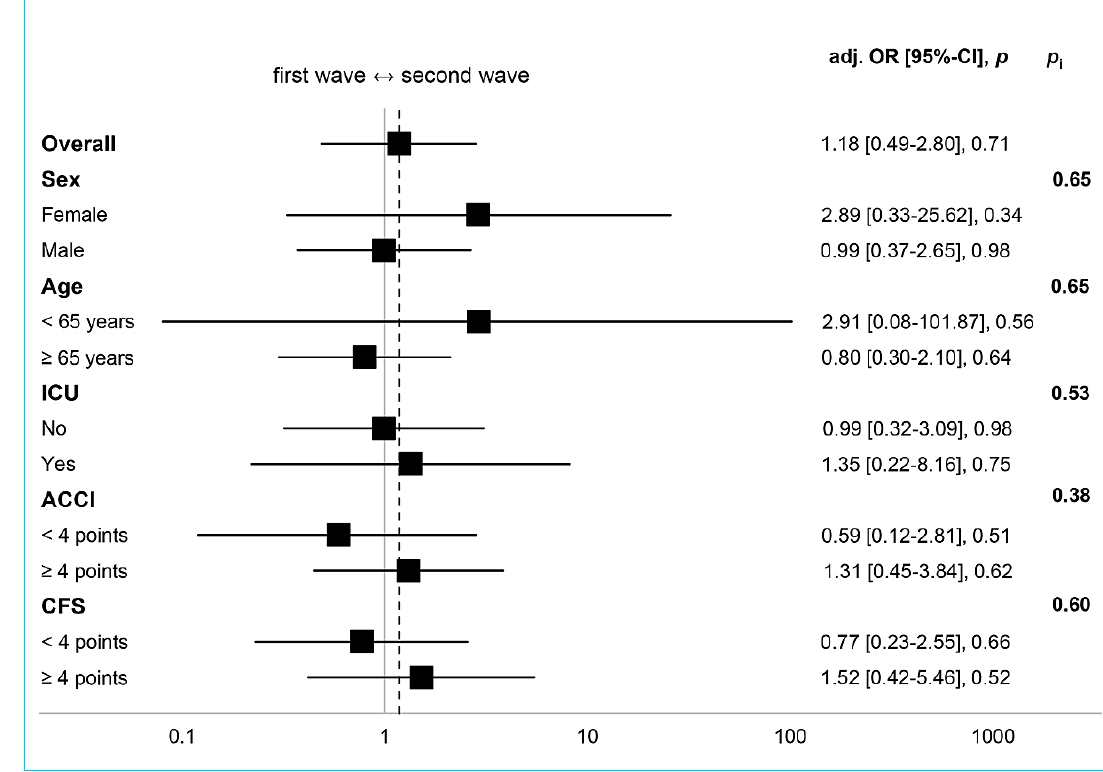
Overall First wave Second Wave p-value * (n = 486) (n = 100)